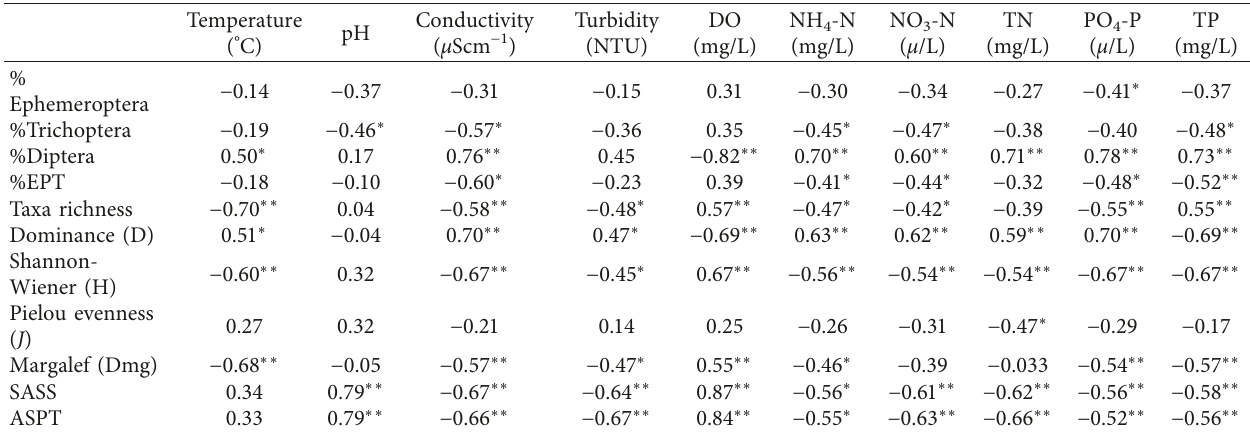
Table 6: Spearman rank correlation coefficients ( r ) between physicochemical variables and macroinvertebrate metrics in Sanyati Basin, with significant correlations highlighted as p < 0 . 05 ( ∗ ) and p < 0 . 01 ( ∗∗